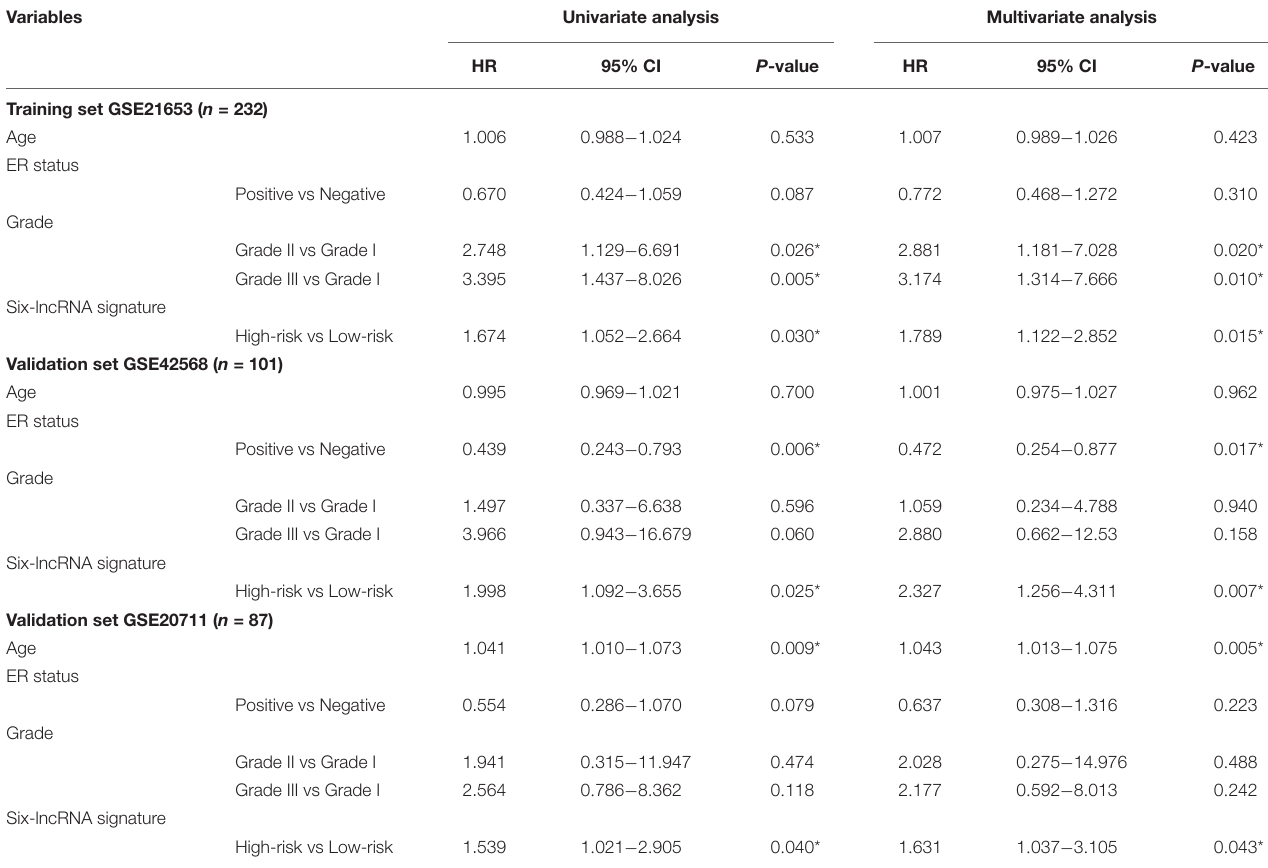
TABLE 3 | Multivariate analysis for the six-lncRNA signature of disease-free survival in cohorts. Variables Univariate analysis Multivariate